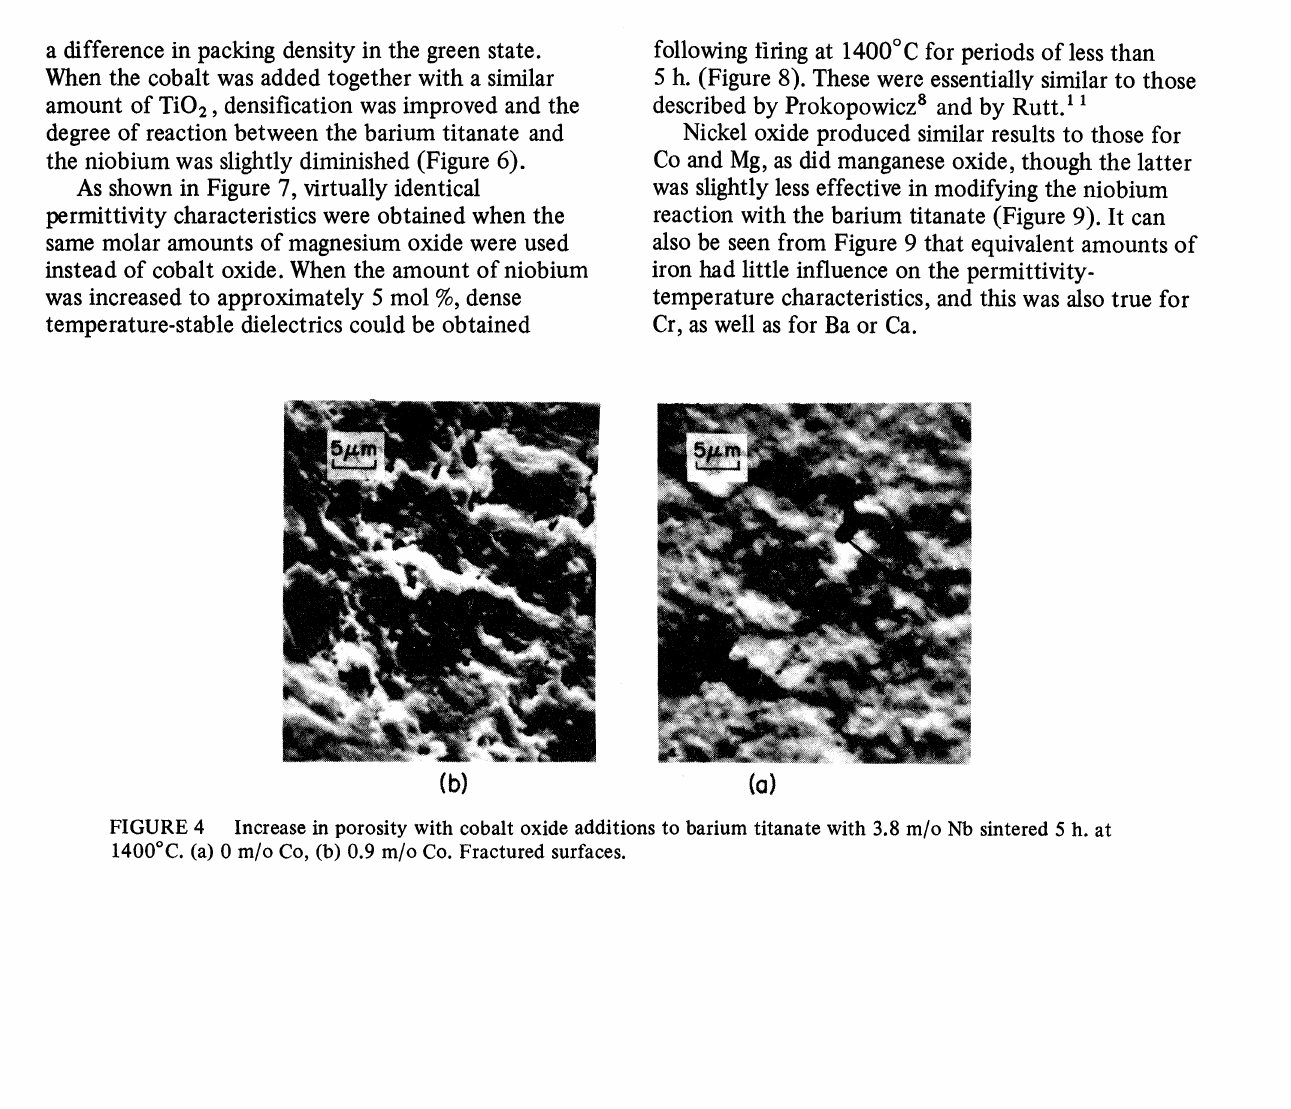
,o / o C Influence of cobalt oxide on the distribution of Nb (S.8 m/o) in barium titanate sitered 5 h. at 1400C. a difference in packing density in the green state.